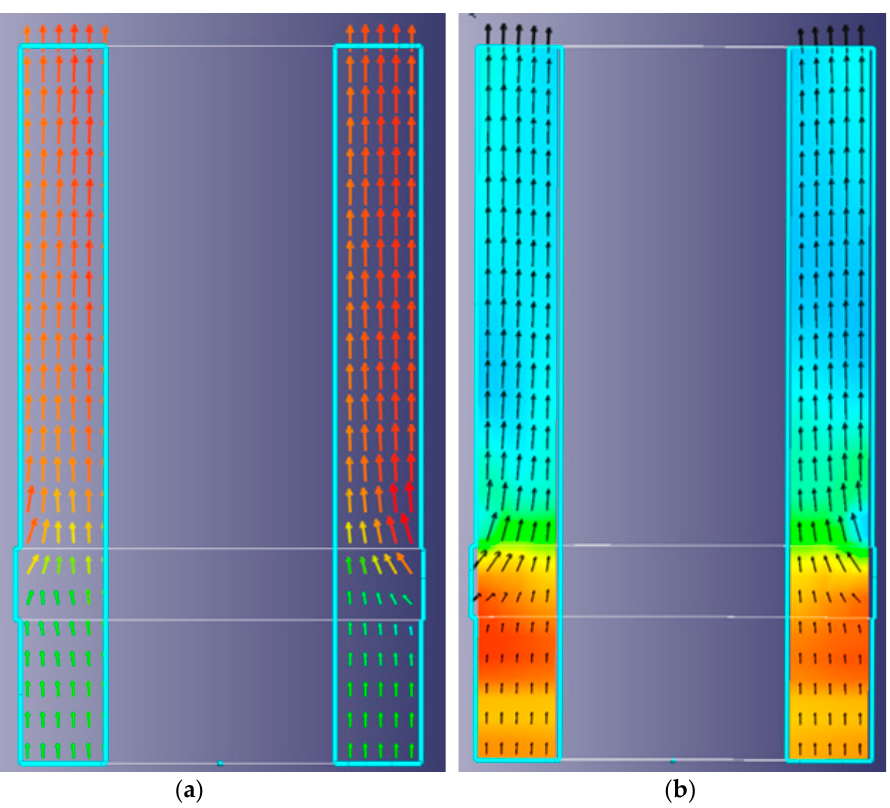
Figure 1. Distribution of air flow velocity ( a ) and pressure ( b ) in a vertical channel at air velocity 𝑉 (cid:3017) = 9 m/s. V P = 9